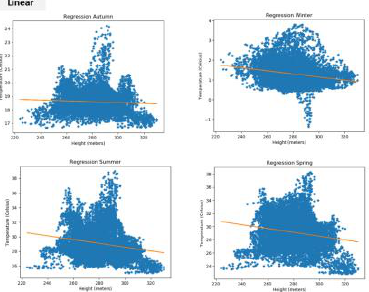
Figure 15: Linear Regression Model LST in 4 seasons (Temperature vs. Height)